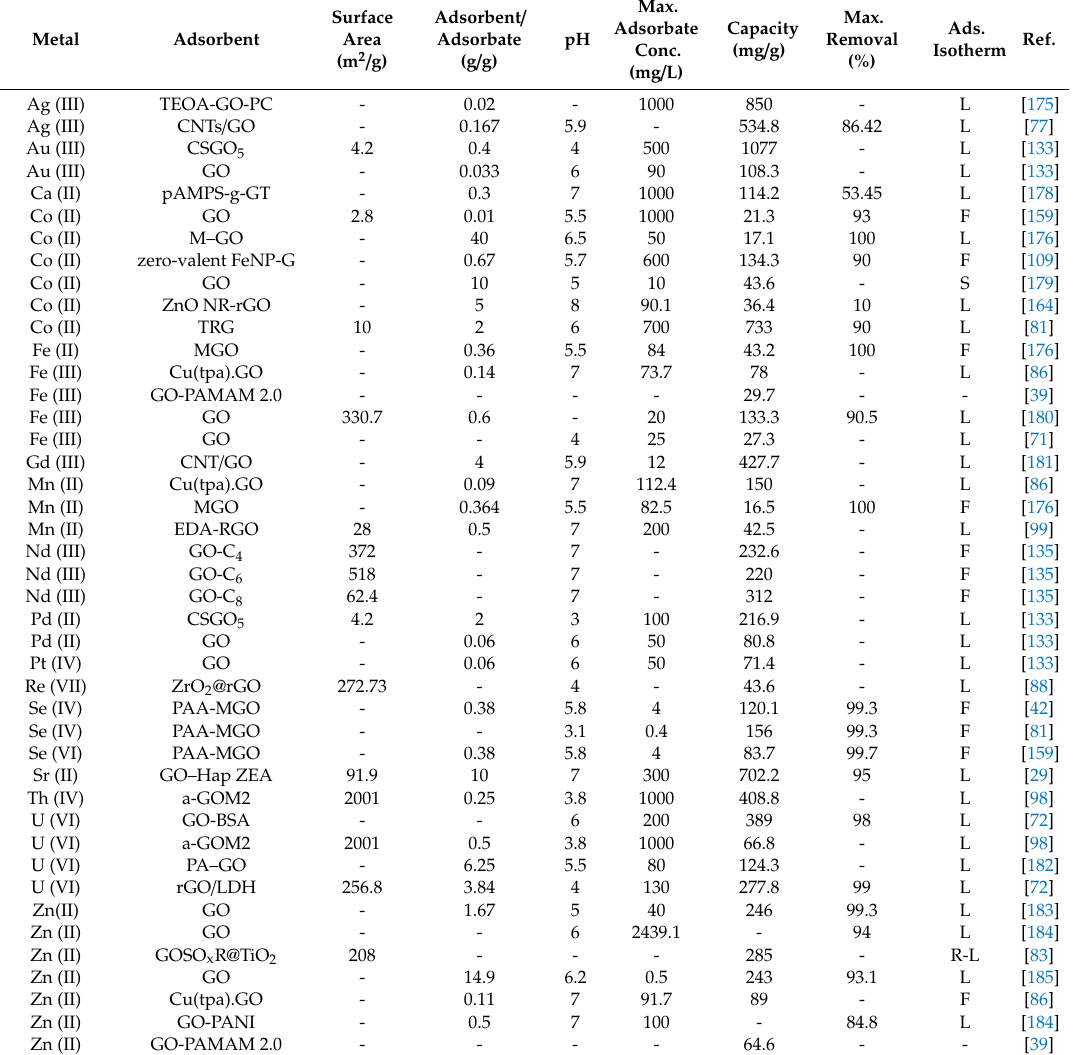
Table 9. Adsorption properties of di ff erent GO-based adsorbents used for removal of various